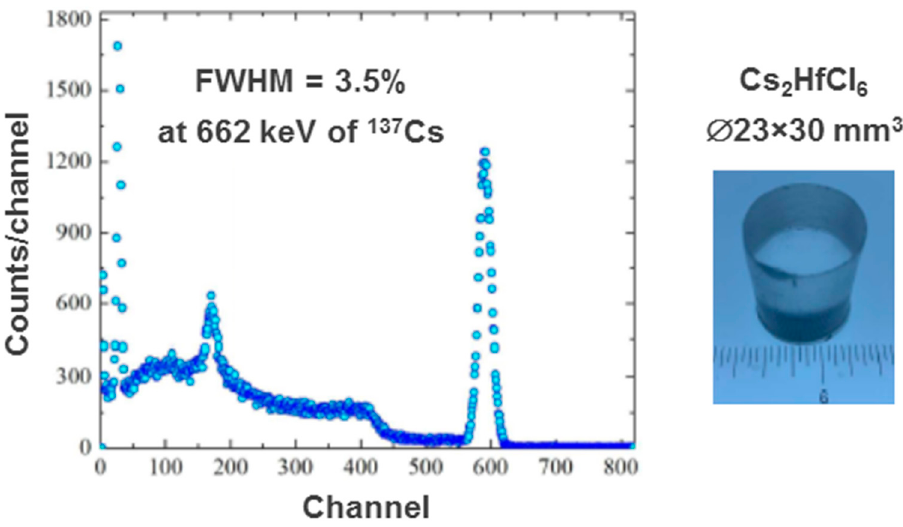
Figure 1. Pulse-height spectrum collected with a ∅ 23 × 30 mm 3 CHC crystal sample resulting in the energy resolution of 3.5% (FWHM) at 662 keV of 137 Cs gamma source (see [13] for more